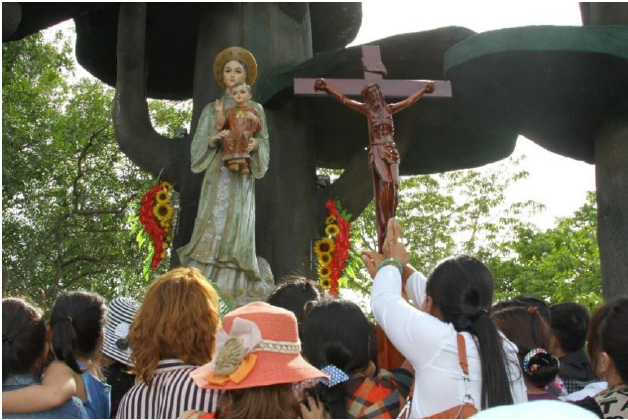
Figure 2. Faithful flock to the Vietnamese-looking statue of Our Lady of Lavang in Lavang (approximately 60 km north of Hue, the former capital of Vietnam, central Vietnam).